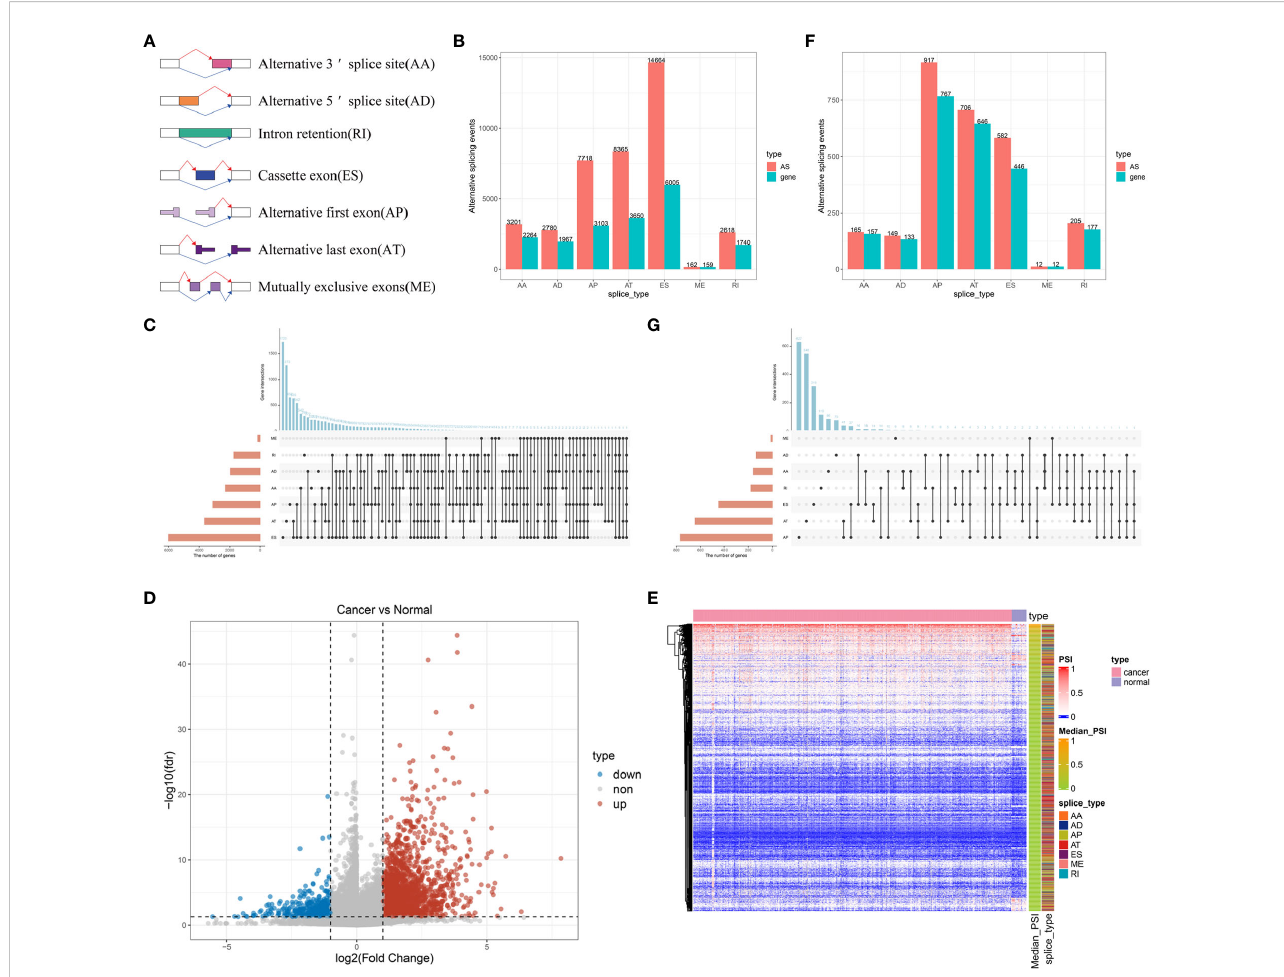
FIGURE 1 Pro fi ling of integrated AS events detected in BLCA. (A) Schematic representation of seven different AS events. (B) The total number of AS events and the corresponding genes for each AS event in BLCA. (C) UpSet plot of interactive genes among seven different types of AS events. (D) Heatmap of CASEs between BLCA and normal tissues (|log2FC| ≥ 1, adjusted P < 0.05). (E) Volcano plot of CASEs identi fi ed in BLCA. (F) The total number of CASEs and the corresponding genes for each AS event in BLCA. (G) UpSet plot of interactive genes among seven different types of